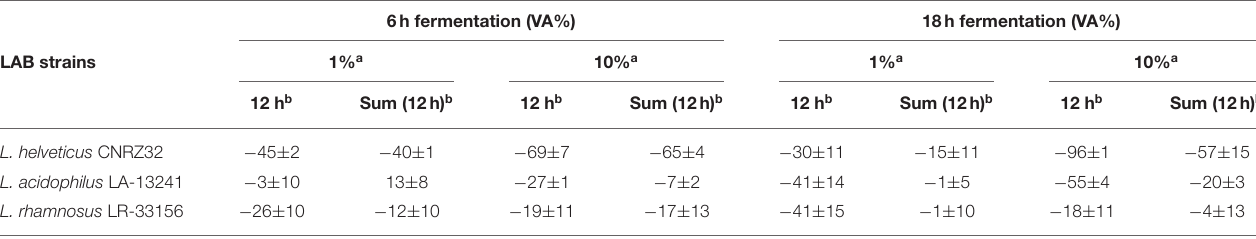
TABLE 3 | The proportional change (VA%) in expression of the virulence gene hilA in S . Typhimurium after growth in nCFSM from L. helveticus CNRZ32, L. acidophilus LA-13241, and L. rhamnosus LR-33156. 6h fermentation (VA%) 18h fermentation (VA%) LAB